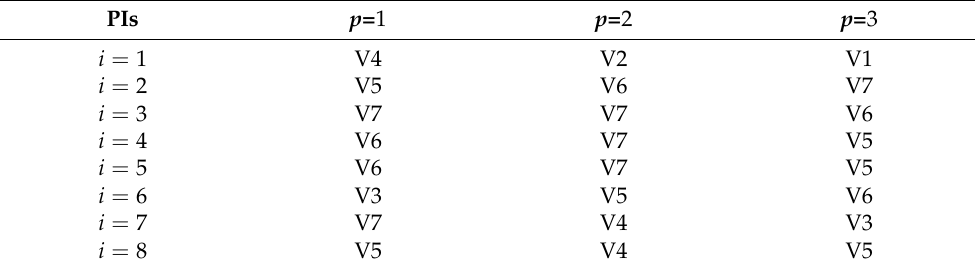
Table 7. The fuzzy decision